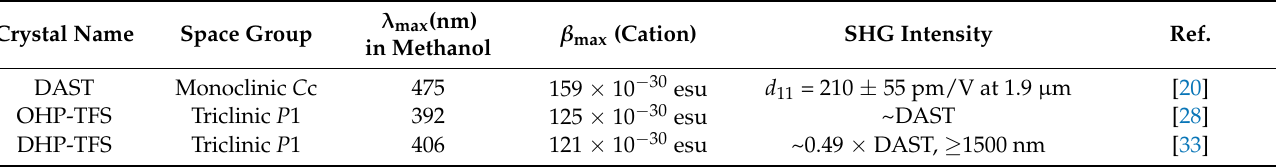
Figure 3. ( a ) The OHP chromophores are perfectly aligned in parallel along the a -axis, and ( b ) 3D network-like interionic interactions between cation layers and anion layers in OHP-TFS [28]; ( c ) catechol induced strong hydrogen bonds between DHP cations and TFS anions, and ( d ) molecular alignment of DHP-TFS crystals [33]. Table 1. Comparison of the mentioned pyridinium-based THz crystals.